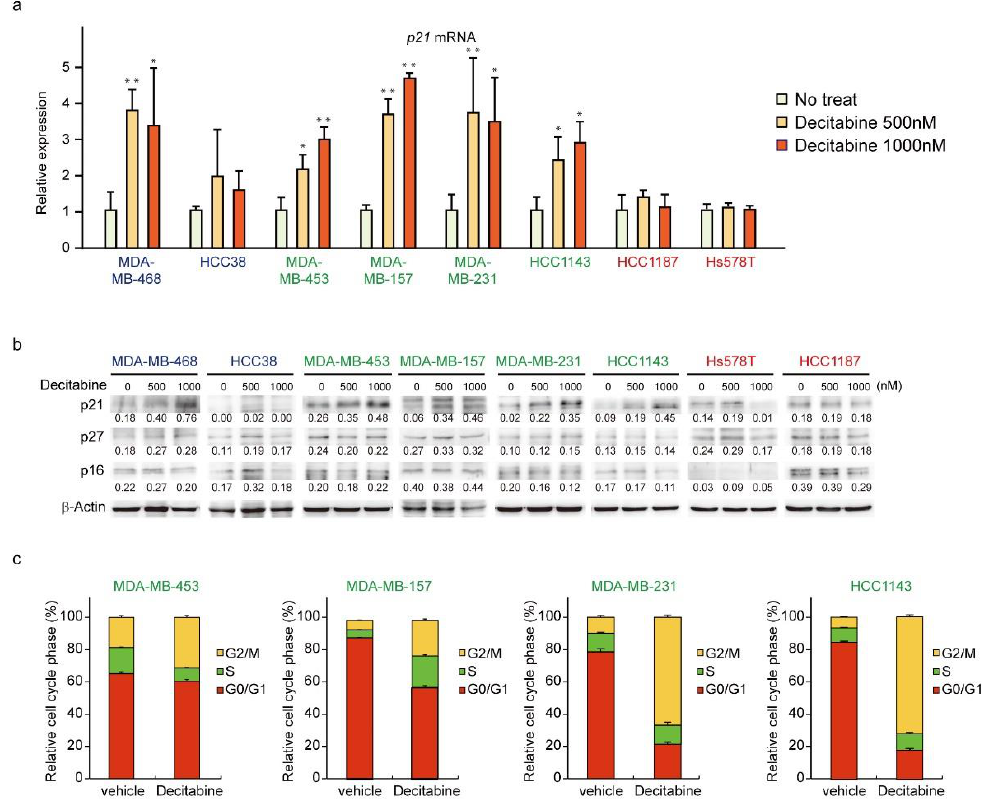
Figure 5. Decitabine induces cell cycle arrest through p21 induction. ( a ) Cells were exposed to the indicated amounts of decitabine (500 nM or 1000 nM). After treatment for 72 h, p21 mRNA was measured by quantitative real-time PCR. ( b ) Cells were exposed to the indicated amounts of decitabine (500 or 1000 nM). After treatment for 72 h, equal amounts of total cell lysate were subjected to immunoblot analysis with the indicated antibodies. Numbers below blots represent the relative band intensity of each protein normalized to the signal intensity of β -actin. The uncropped immunoblot images can be found in Figure S4. ( c ) Relative cell cycle phase was quantified by flow cytometry analysis of propidium iodide–stained cells. Error bars indicate SD ( n = 3). The data are expressed as the mean ± SD of triplicate experiments. *, p < 0.05; **, p < 0.01.